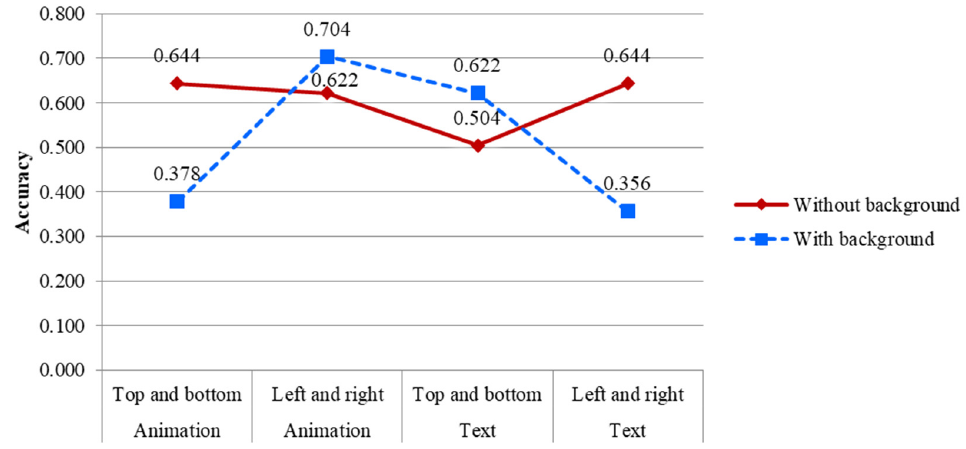
Figure 3. The interaction among background, film type, and arrangement for accuracy.